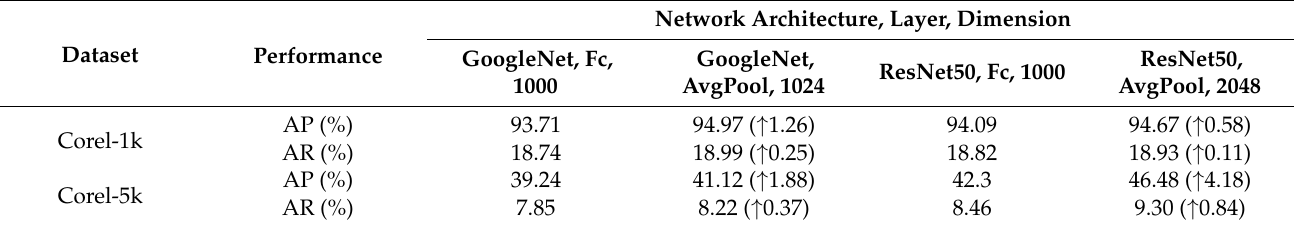
Table 5. APs and ARs results by using deep features extracted from different layers, Top NR = 20.